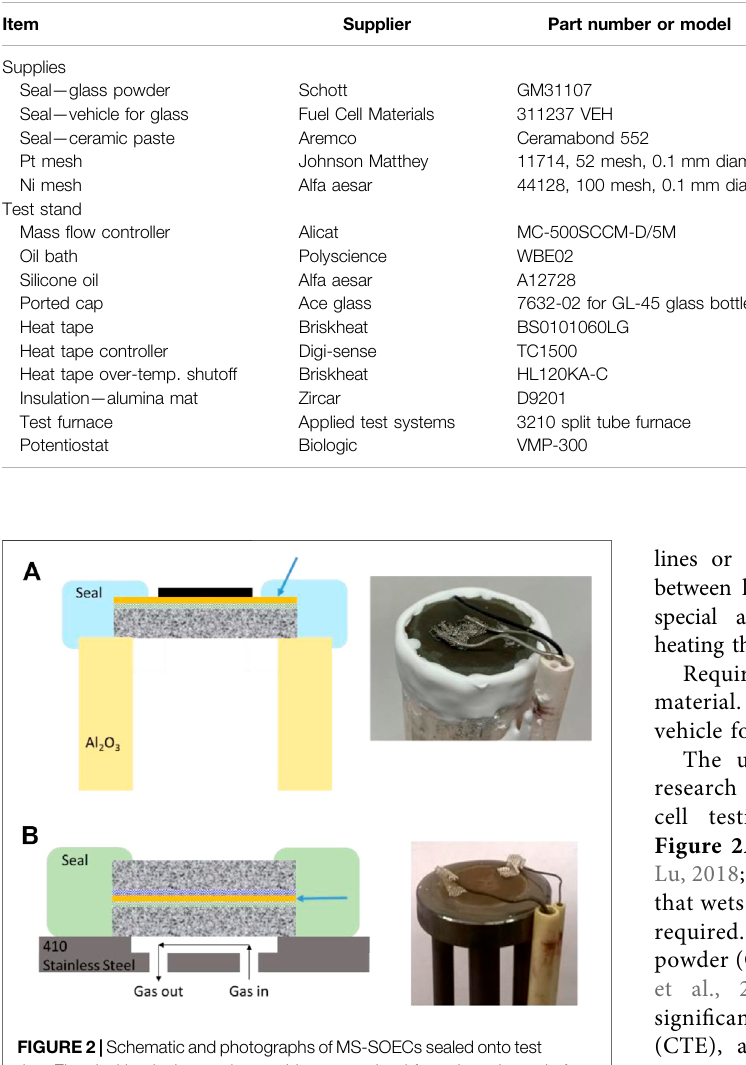
TABLE 1 | List of suitable supplies and test stand equipment.